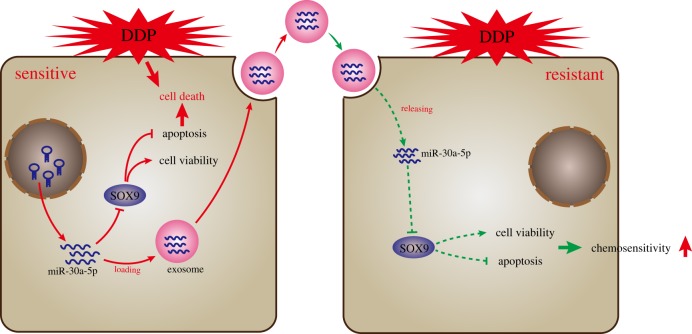
The proposed regulatory mechanism illustrating that exosomes carrying miR-30a-5p increased the sensitivity of OC cells to DDP by targeting SOX9. In DDP-resistant OC cells SKOV3/DDP, miR-30a-5p promoted apoptosis and inhibited cell viability by targeting SOX9 after DDP stimulation. In addition, miR-30a-5p could be transferred into exosomes from DDP-sensitive SKOV3 cells and then delivered into DDP-resistant SKOV3 cells, thereby promoting cell apoptosis, inhibiting cell proliferation and ultimately increasing chemosensitivity of DDP-resistant SKOV3 cells.